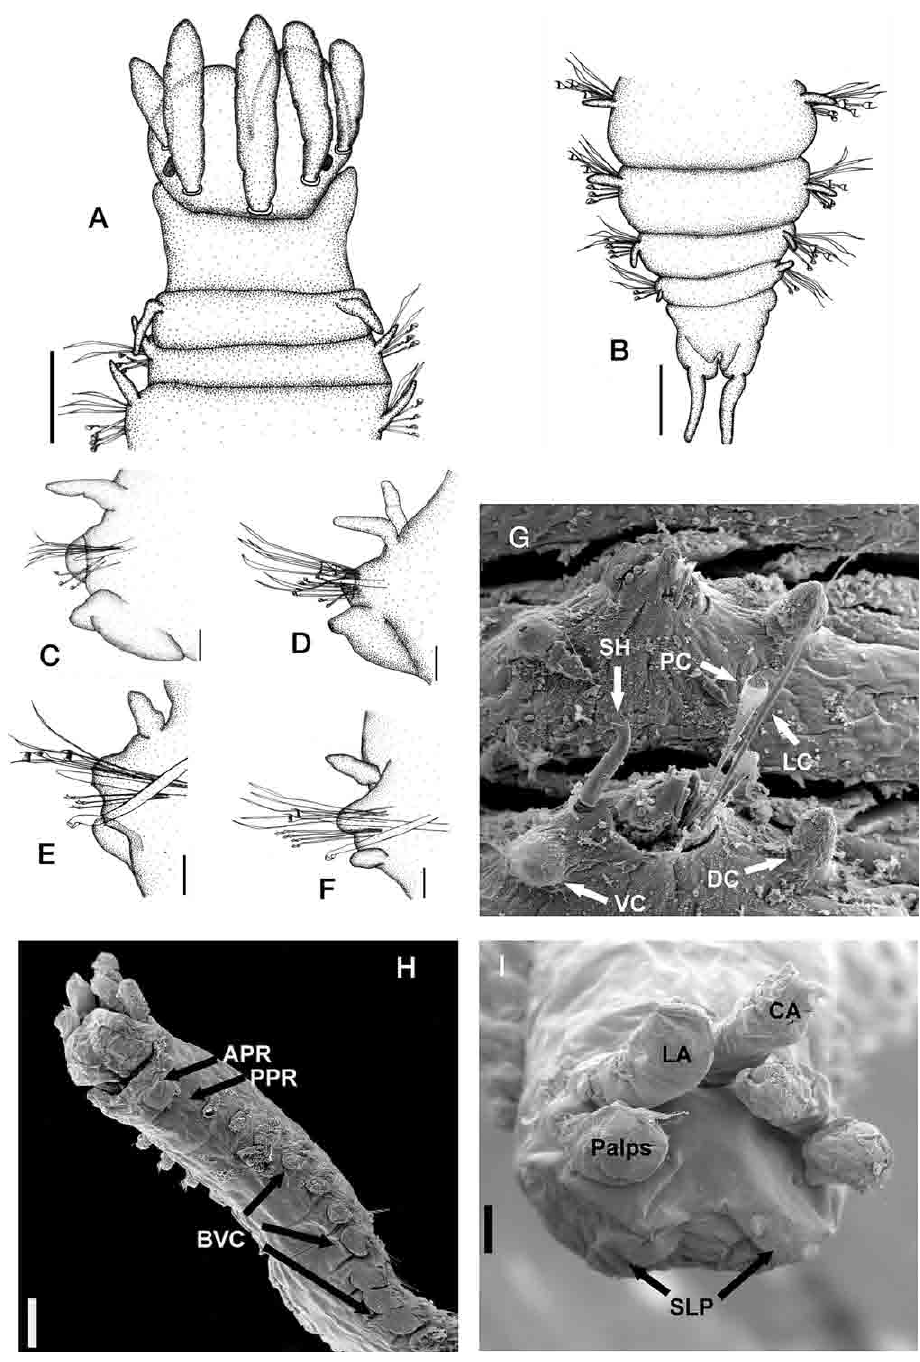
F IG . 1. – Eunice insularis sp. n. A, anterior end, dorsal view; B, pygidium, dorsal view; C, G: parapodia: C, chaetiger 15; D, chaetiger 15 (individual from São Sebastião Island), E, chaetiger 52, F, chaetiger 132, G, chaetiger 63; H, anterior end, lateral view; I, anterior end, frontal view. APR, anterior peristomial ring; BVC, bases of ventral cirri; CA, central antenna; DC, dorsal cirrus; LA, lateral antennae; LC, limbate chaetae; PPR, posterior peristomial ring; PC, pectinate chaetae; SH, subacicular hook; SLP, superior lip projections; VC, ventral cirrus.